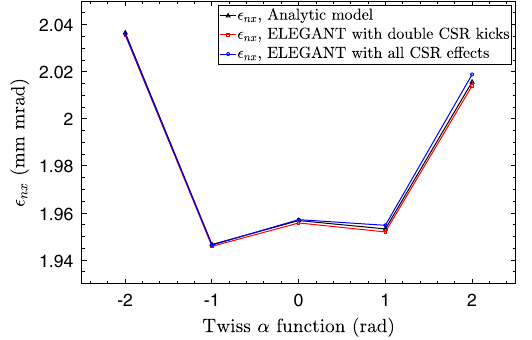
FIG. 12. Emittance variation as a function of the initial Twiss α function. Here, emittance is the value after the achromatic dog-leg transfer line with consideration of both higher-order terms and the CSR